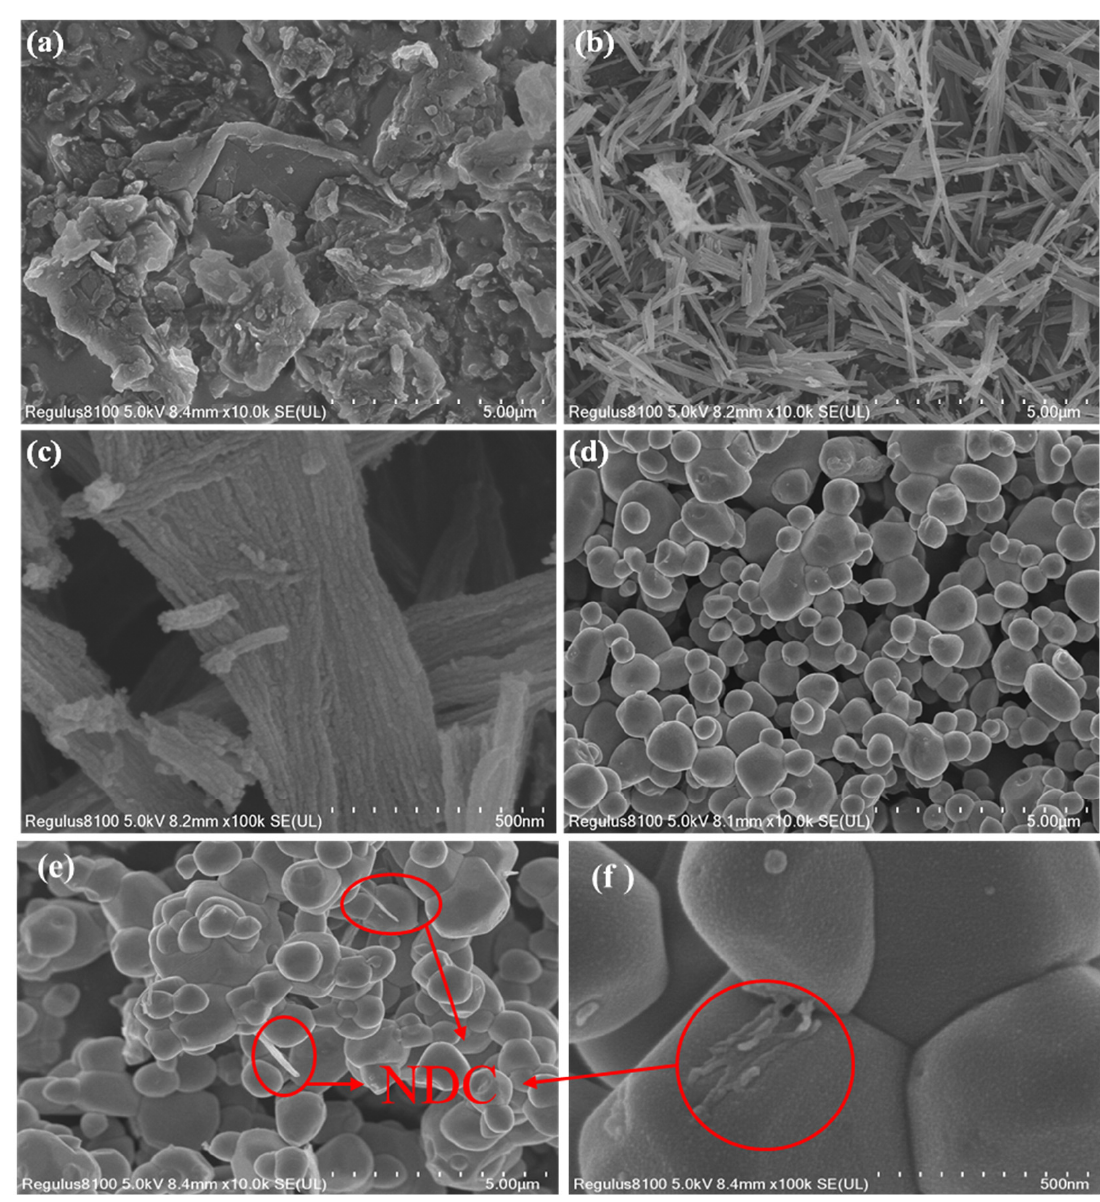
Figure 1. SEM images of ( a ) PU, ( b , c ) NDC, ( d ) Ag 3 PO 4 and ( e , f ) Ag 3 PO 4 @NDC. To determine the microstructure and element composition, the TEM (TecnaiG2 F20, FEI) images of the photocatalyst were tested. Figure 2a–c was the TEM images of NDC at dif- ferent